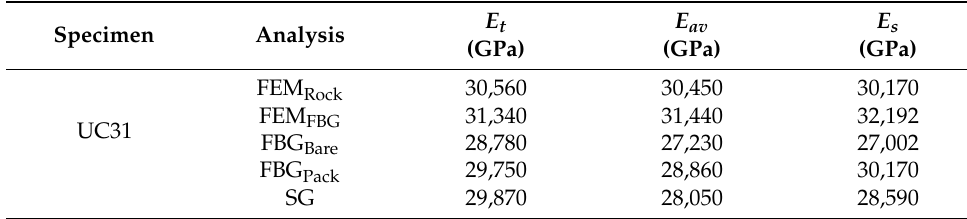
Table 7. Comparison of stiffness parameters of FEM and experimental results.